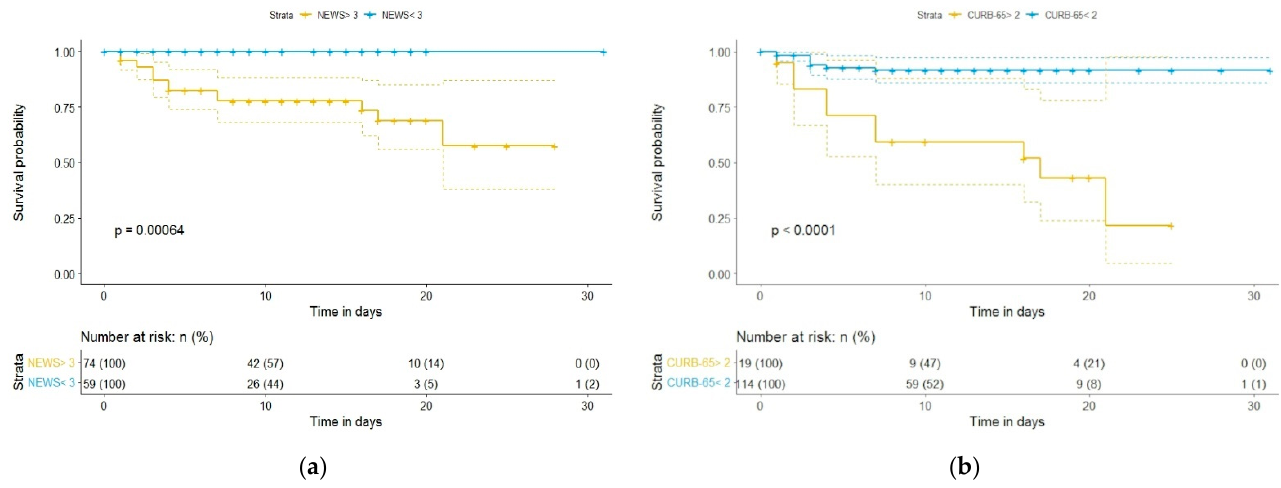
Figure 5. Kaplan–Meier survival curves of hospitalized COVID-19 patients: ( a ) according to NEWS cutoff value of 3; ( b ) according to CURB-65 cutoff value of 2. Table 5. Univariate logistic regression analysis of mortality risk